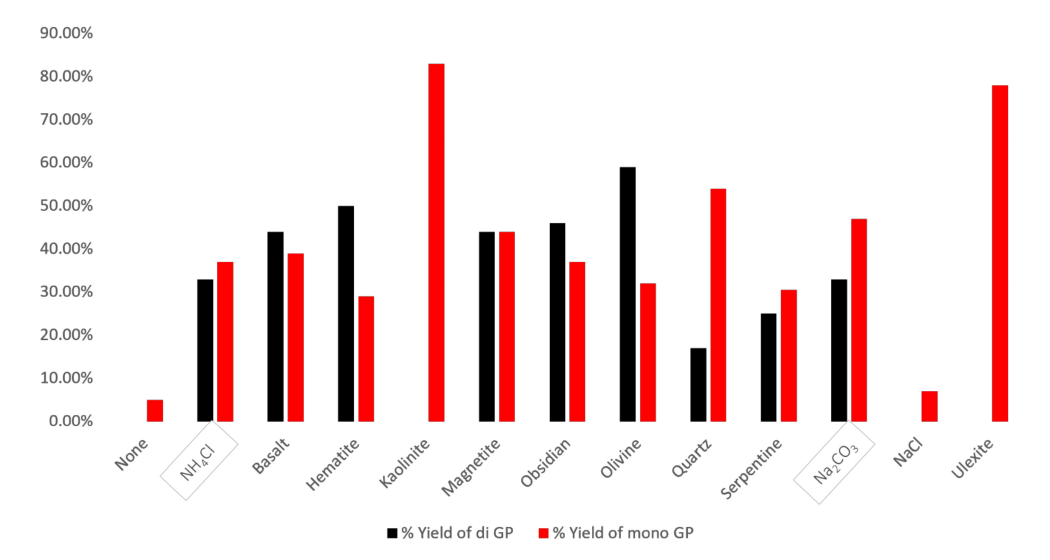
Figure 4. The comparable yields (%) of mono GP (glycerol-1-phosphate, glycerol-2-phosphate and cyclic mono GP) and di GP in the presence of various